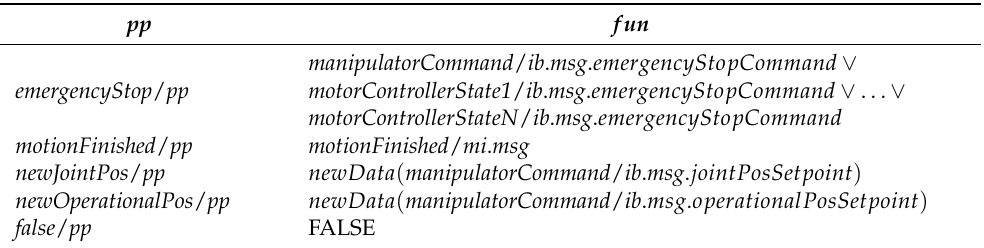
Table 5. Definitions of manip / a . cs . pp . fun